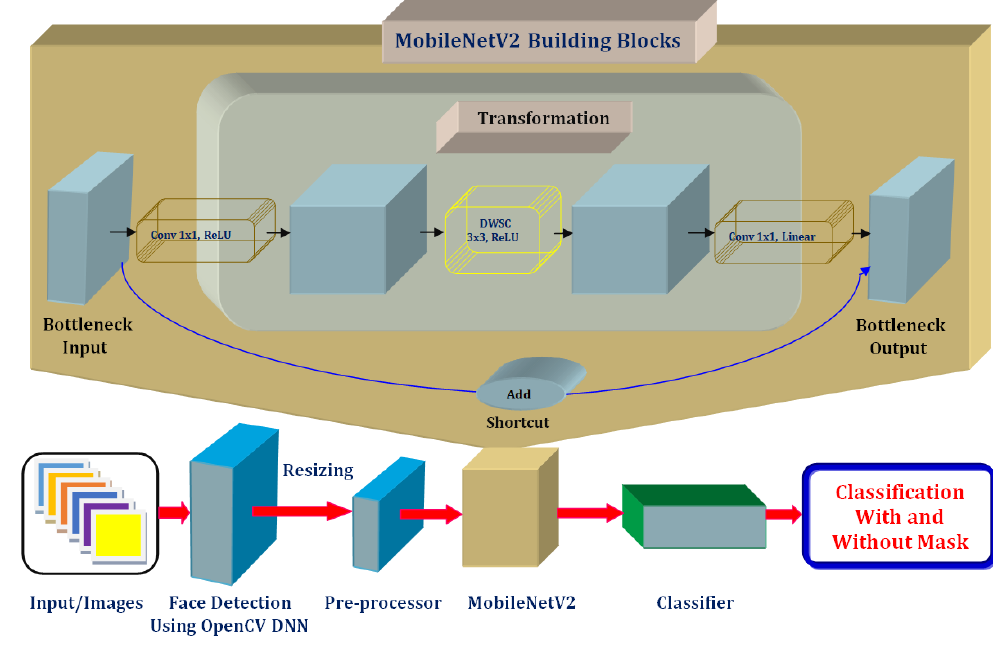
Figure 1. MobileNetV2